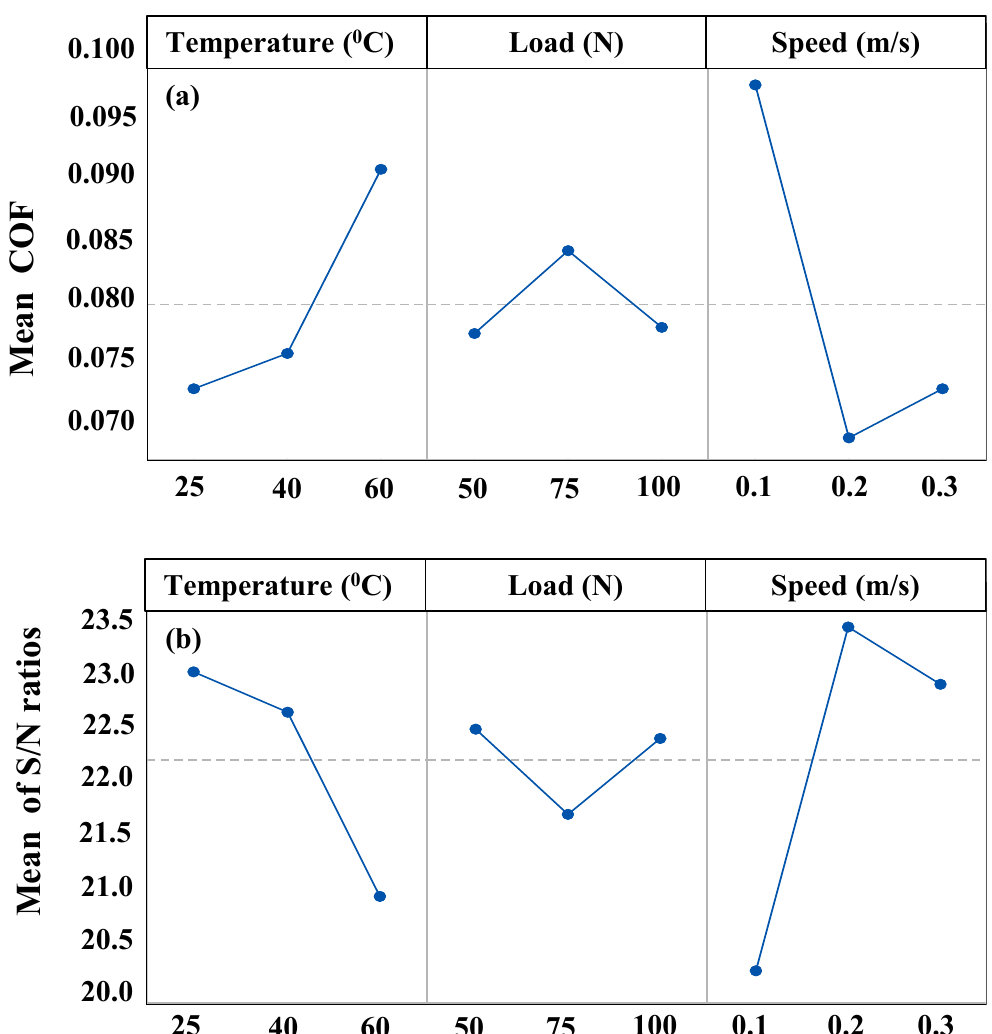
Figure 4. ( a ) main effects plot for the coefficient of friction; ( b ) main effects plot for the mean S/N ratios, smaller is better.